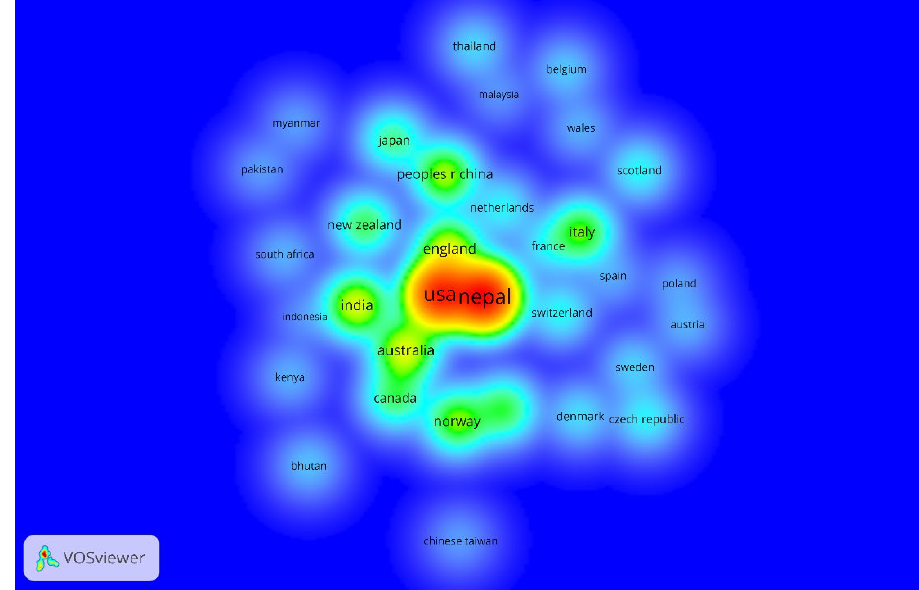
Figure 15. Density map of countries and regions.